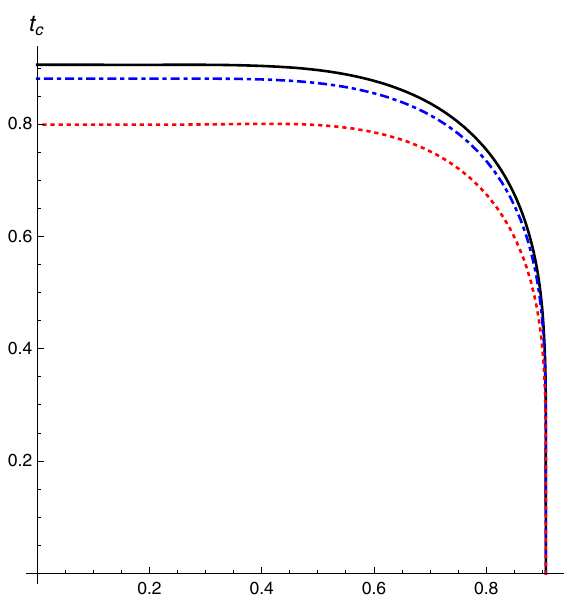
Fig. 1 Phase diagram ( ξ × t c ) for fixed values of the magnetic field, δ = 8 . 0, and the coupling constant, λ = 2 . 0, and three values of the chemical potential: γ = 0 . 0; 0 . 35; and 0 . 7, corresponding to the full , dotdashed and dotted lines respectively